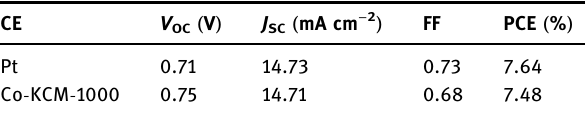
Table 8: DSSC photovoltaic parameters for Co - KCM - 1000 - and Pt -